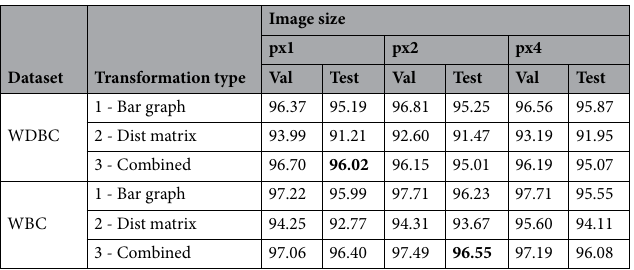
Table 4. Average results for classification accuracy. Significant values are in